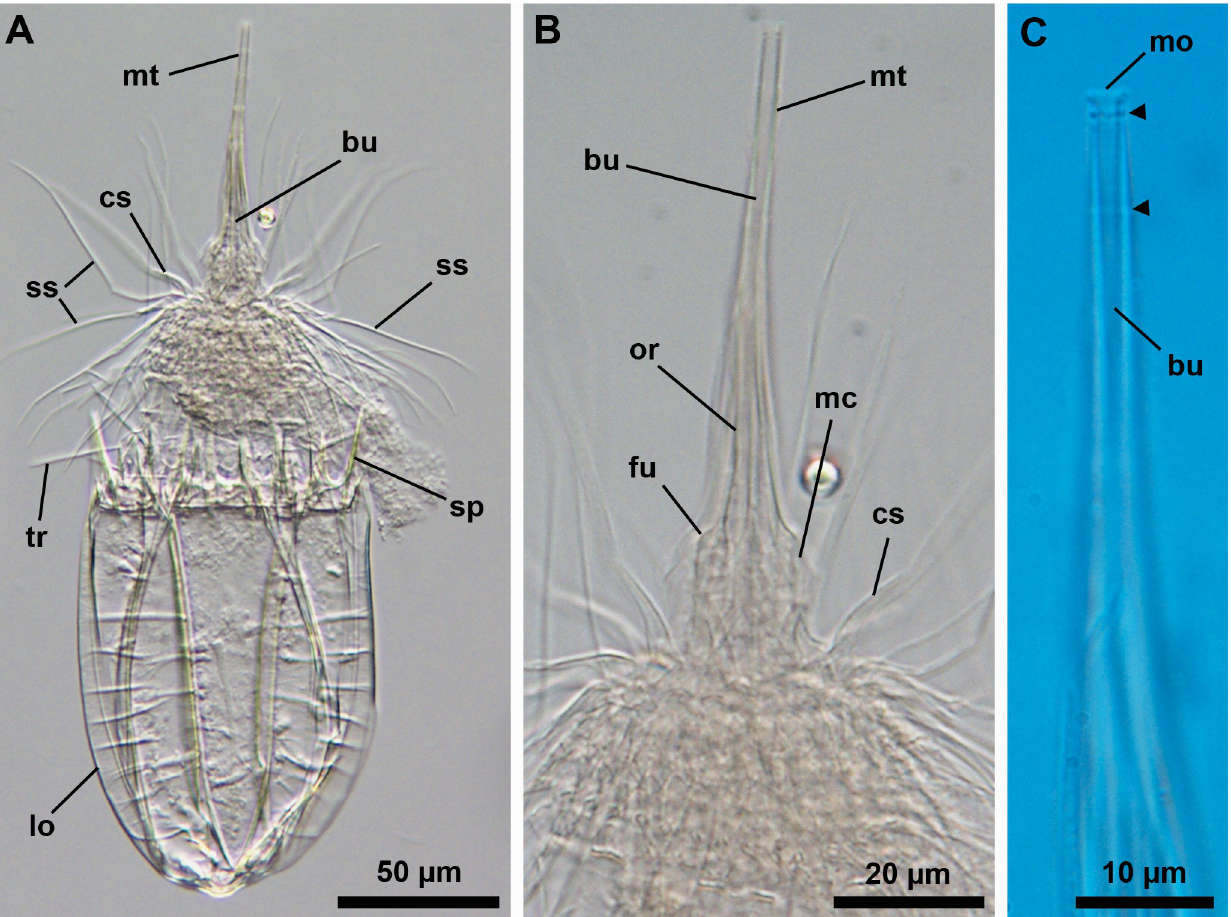
Fig 12. Light micrographs of a paratypic adult female of Nanaloricus mathildeae sp. nov. Anterior faces up in all aspects. (A) Overview of the fully extended specimen. Note that the mouth tube is fully extended. (B) Close up of the anterior region of the body. (C) Detail of the anteriormost region of the mouth tube. Short, black arrowheads point to ring-like thickenings of the fully extended mouth tube. Abbreviations: bu, buccal tube; cs, clavoscalids; fu, oral furca; lo, lorica; mc, mouth cone; mo, mouth aperture; mt, mouth tube; or, oral ridge; sp, anterior spike; ss spinoscalid; tr, trichoscalid.